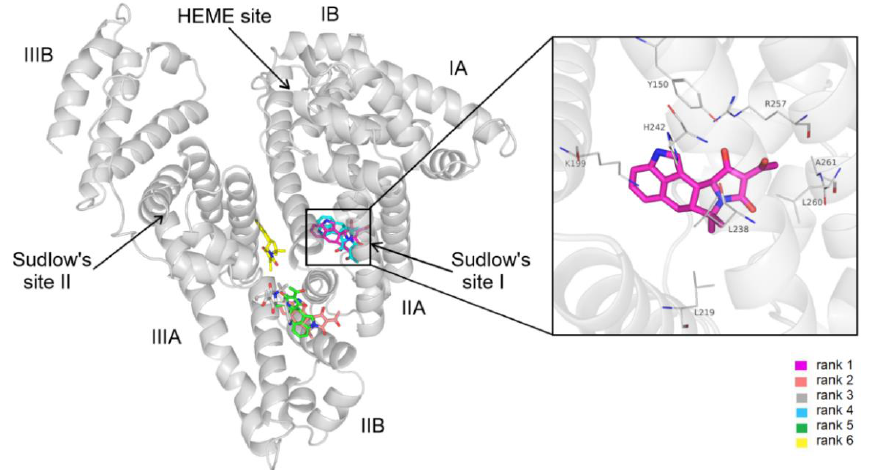
Figure 4. Blind docking results of CPA (sticks colored by docking ranks) on HSA (gray cartoon) with the representative binding positions of different ranks (left panel). In the right panel, a close-up of the binding mode in regard to rank 1 is demonstrated, representing the best energy score in the inset with interacting HSA residues (sticks colored by atom types).